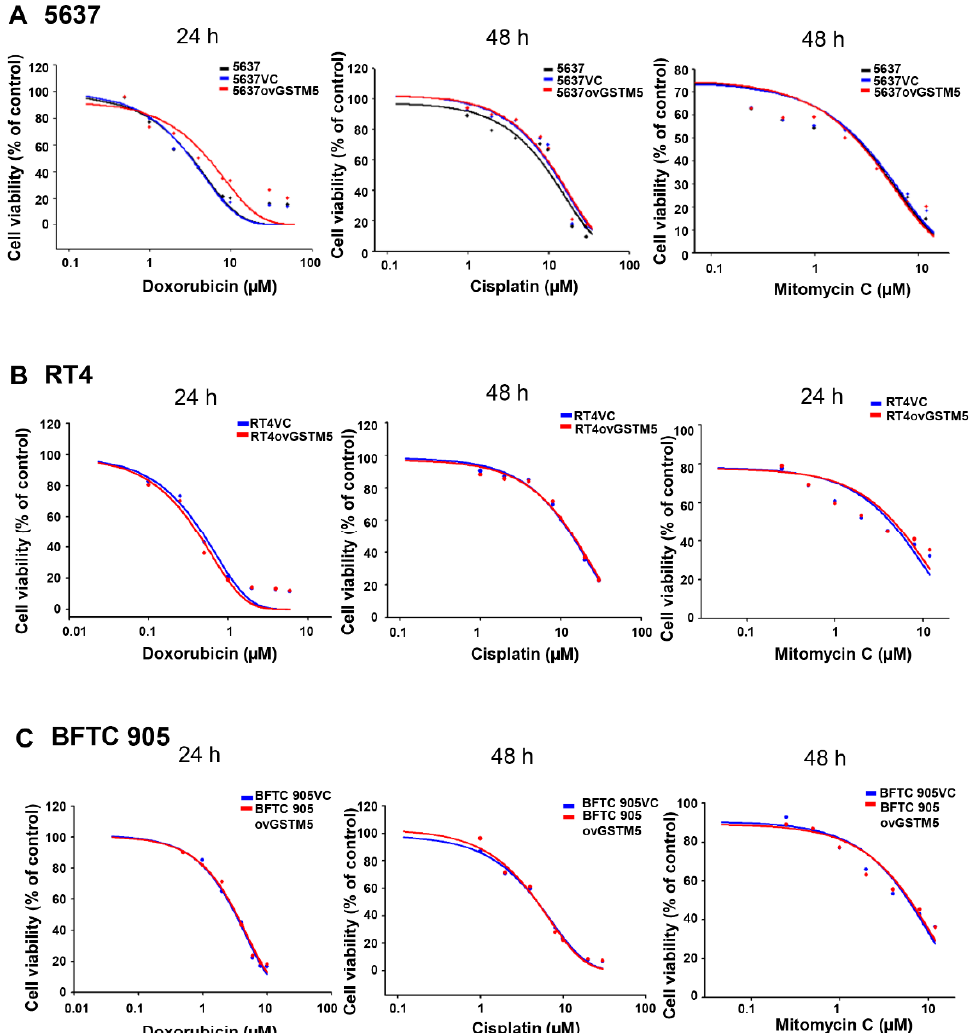
Figure 8. GSTM5 overexpression does not significantly alter the sensitivity of cells to doxorubicin, cisplatin and mitomycin C. ( A ) The drug sensitivity of 5637, 5637VC and 5637ovGSTM5 cells ( B ) drug sensitivity of RT4VC and RT4ovGSTM5. ( C ) Drug sensitivity of BFTC 905VC and BFTC 905ovGSTM5. Cells were analyzed in a wide-range drug concentration by MTT assay. The individual drug treatment times are displayed above each data.